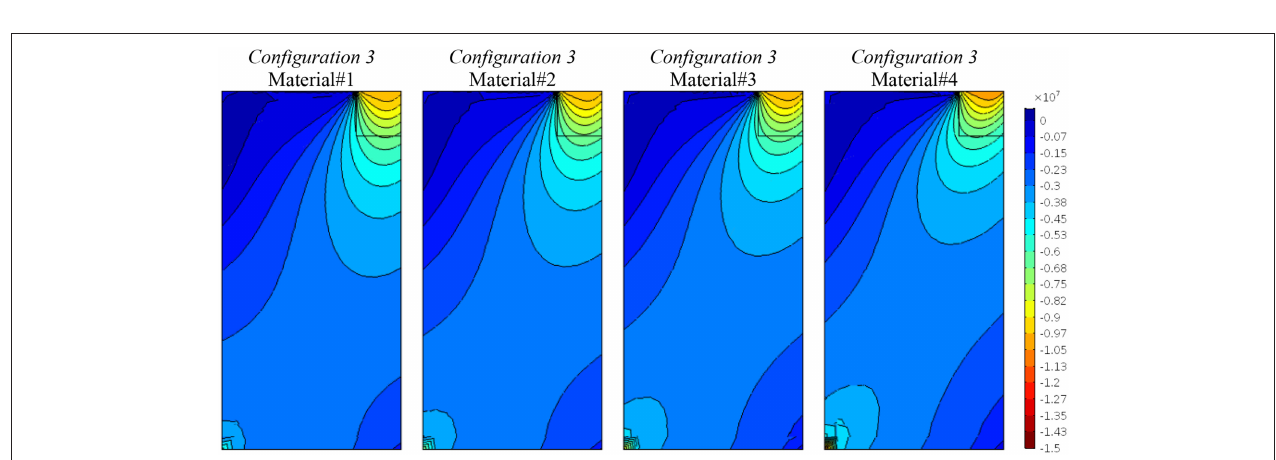
FIGURE 9 | Configuration 3, vertical stress component, σ 22 , contour plots for four material cases (Material#1/Material#4 minimum/maximum anisotropy degree).